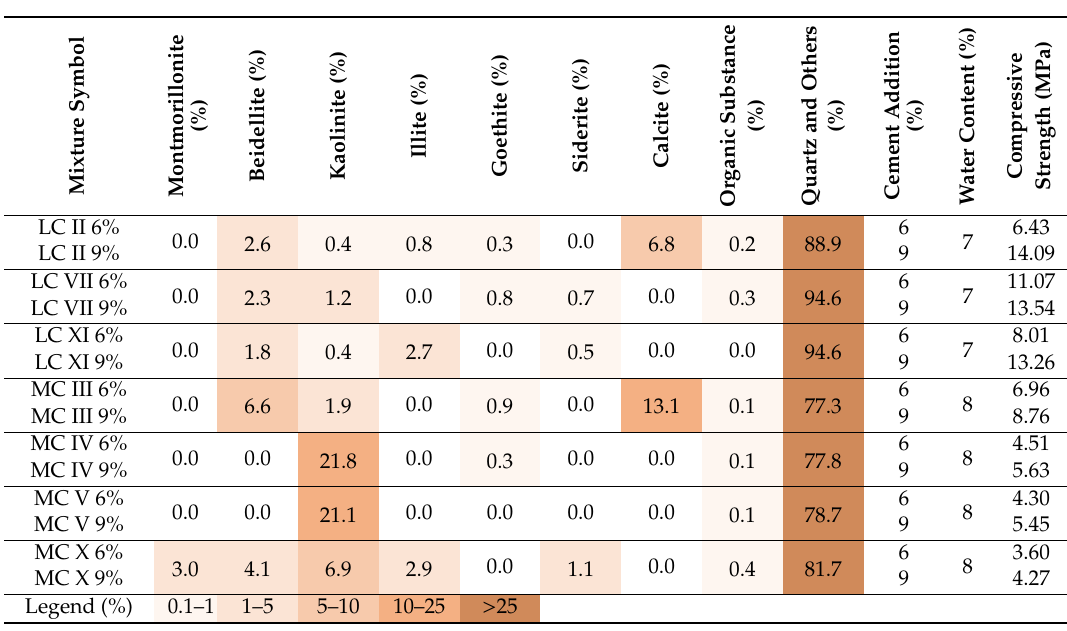
Figure 8. Compressive strength of the CSRE sample series with 6% cement content. Horizontal lines mark the minimum and maximum value in the sample series, while the round points mean the average value. Table 5. Mineral compositions of soil mixtures given in percentages. The table also gives the percentage of water and CEM I 42.5 R cement additions and the average obtained compressive strength of CSRE samples in each